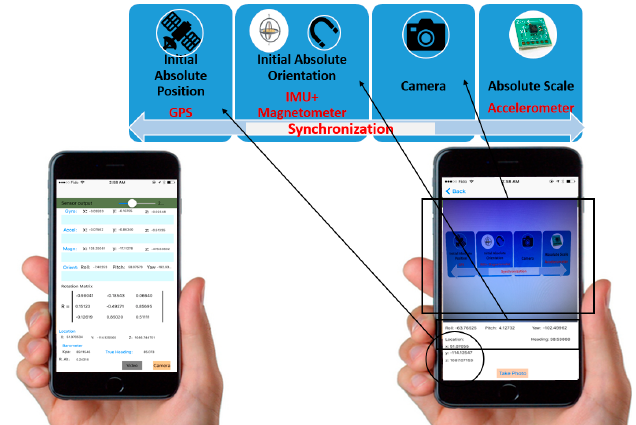
Figure 2. Developed iOS application.